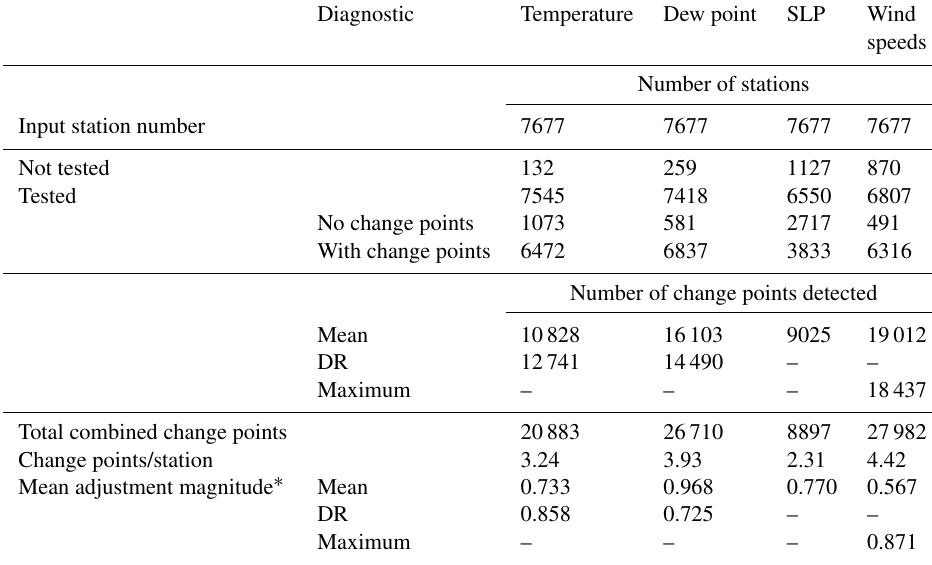
Table 2. Update of Table 1 in Dunn et al. (2014). The number of stations used and the number which had too few neighbouring stations for each of the four variables. The number of change points detected for the calculation methods used for each variable, along with the number per station (excluding those with too few